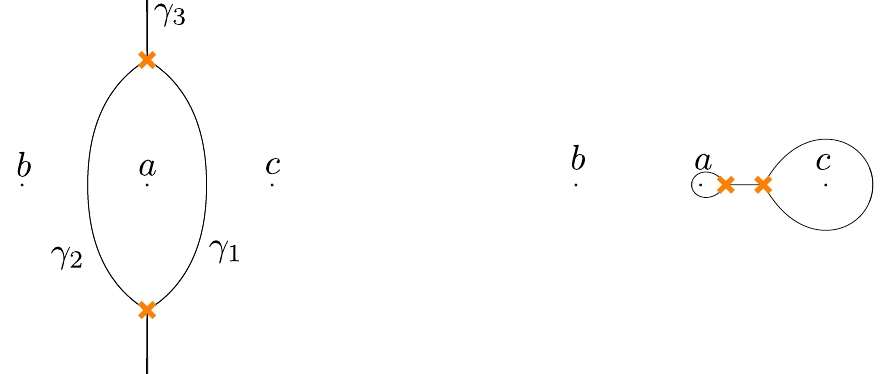
Figure 9. Two BPS graphs of the T 2 theory. In the left graph, the edge labeled by (cid:13) 3 runs around CP 1 and connects the two branch